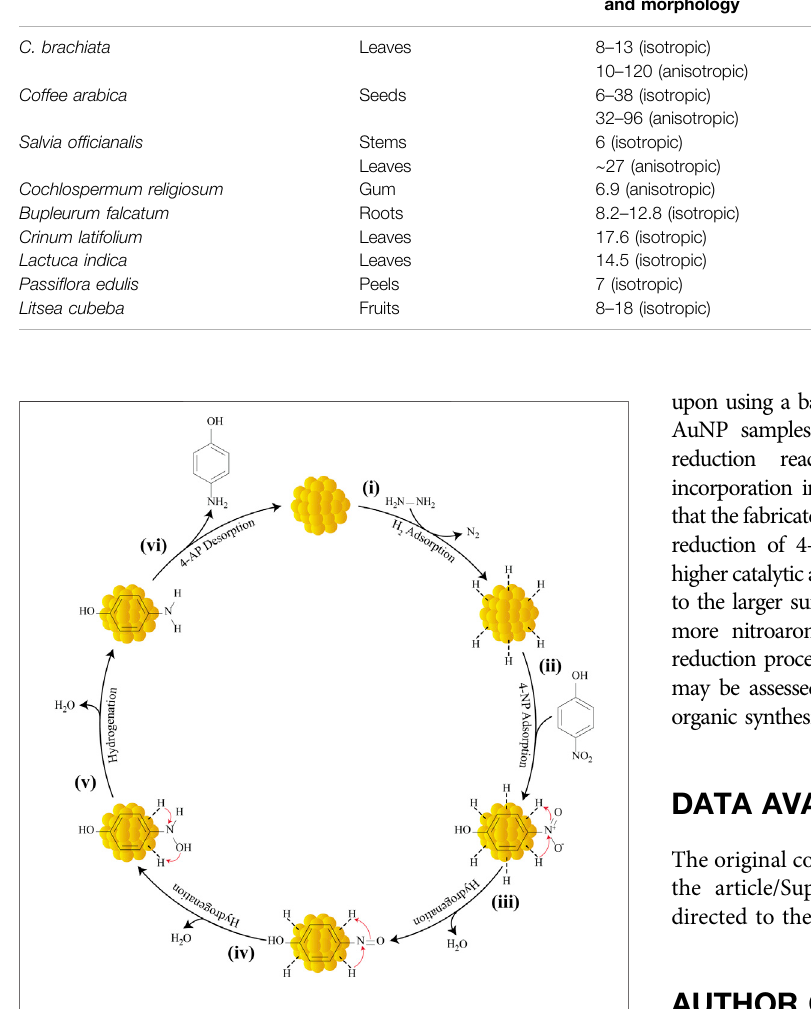
TABLE 2 | Comparative literature data of several plant-mediated AuNPs applying catalytic reduction of 4-NP. Plant Plant